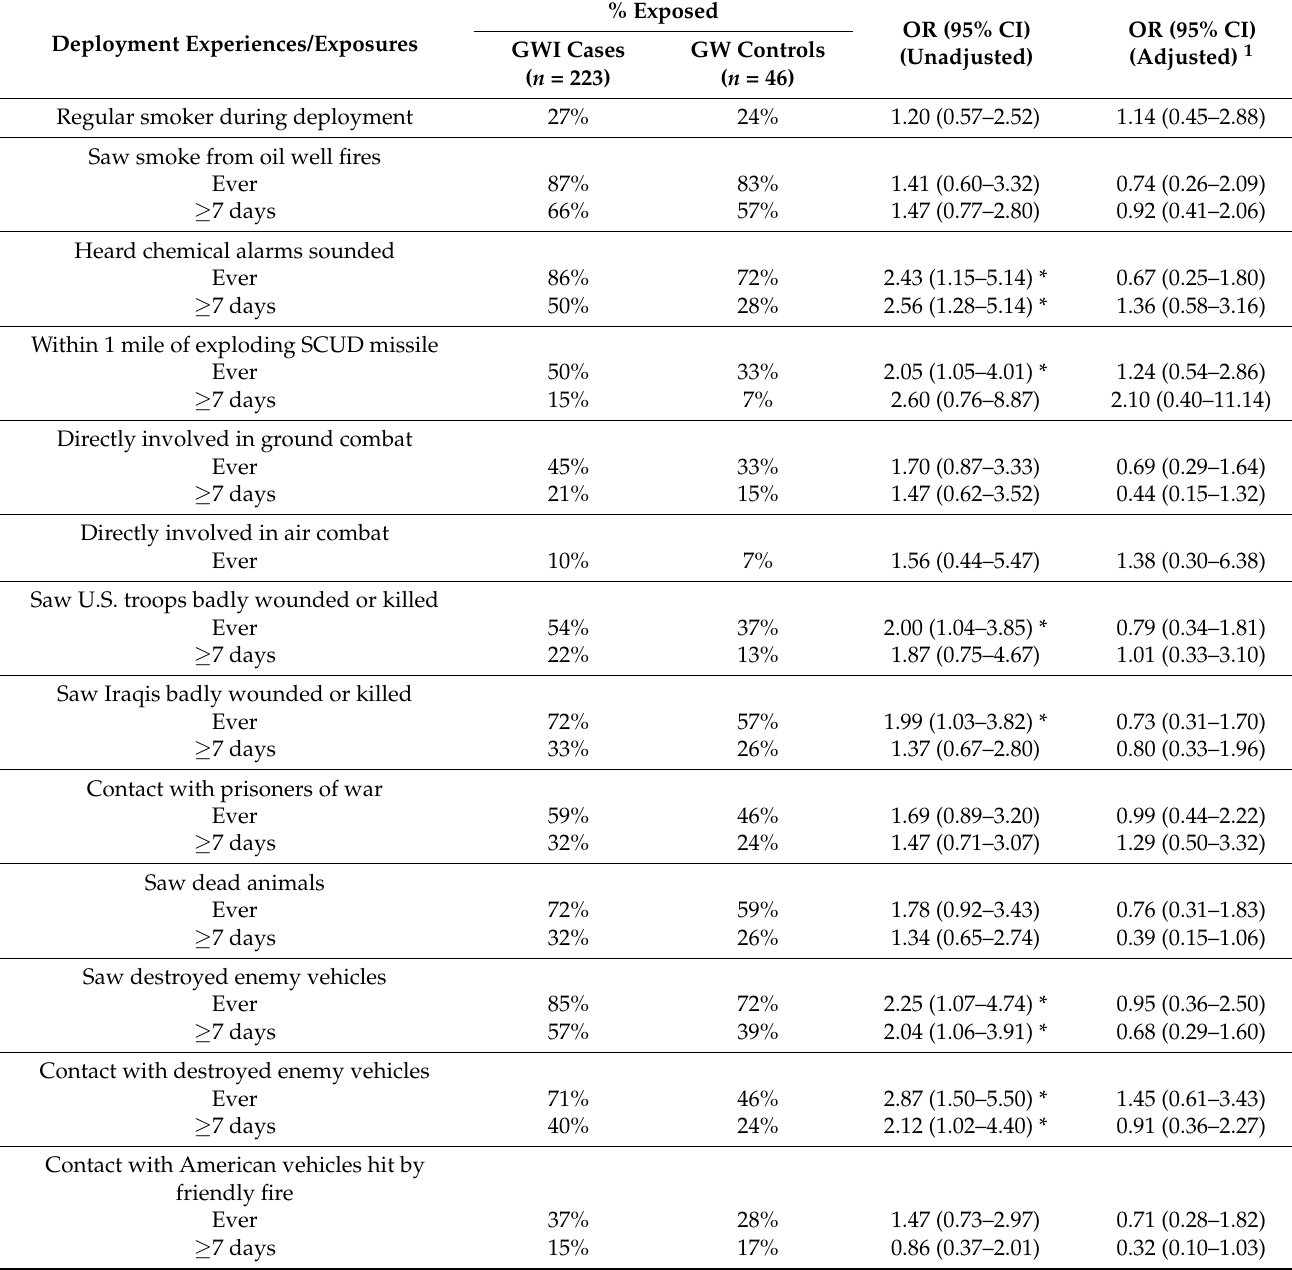
Table 4. Association of GWI case status with Gulf War deployment experiences and